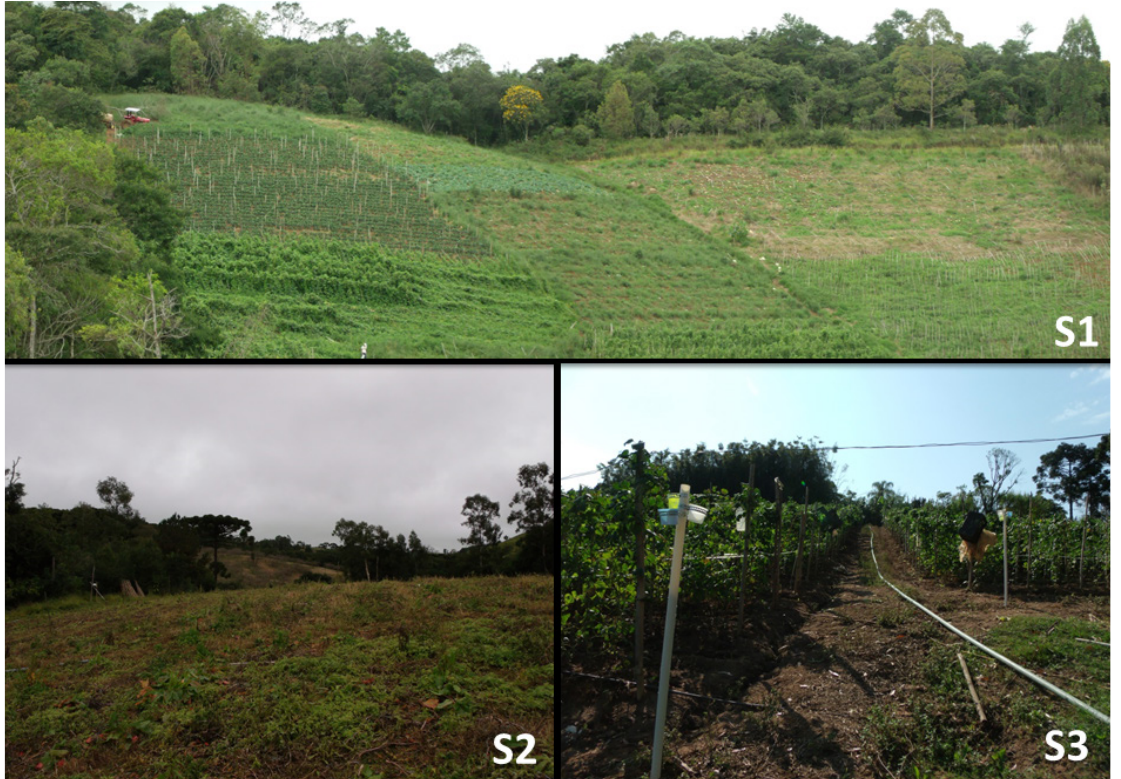
Fig 1 . Smallholder rural properties overview. S1: property S1 showing cultivated and post-harvest areas. S2: property S2 showing a post-harvest area. S3: property S3 showing flat bean